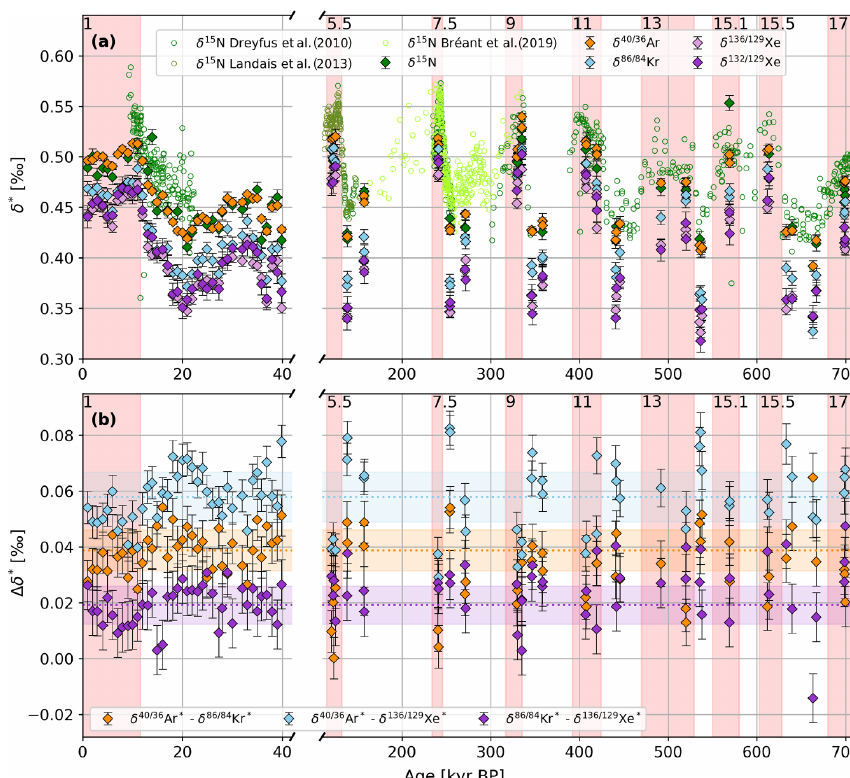
Figure 3. (a) Isotopic enrichment of the EDC samples from 700kyrBP to the present. All isotopic data are shown per unit mass difference and reported relative to modern air sampled in Bern, Switzerland. The data are corrected for thermal fractionation as described in the text. In the case of δ 15 N, data points contaminated with drilling fluid have been excluded. The circles in darker green, olive, and lighter green represent measurements from the EDC ice core from Dreyfus et al. (2010), Landais et al. (2013), and Bréant et al. (2019), which have been corrected for thermal fractionation using our model-derived firn temperatures. (b) Difference between the isotopic ratios of the EDC samples after correction for thermal fractionation. The dashed line is the mean difference from the samples over the last 40kyr, with the shaded areas representing their standard deviation. The red shaded intervals and the MIS numbers on top indicate interglacials as identified by Masson-Delmotte et al.